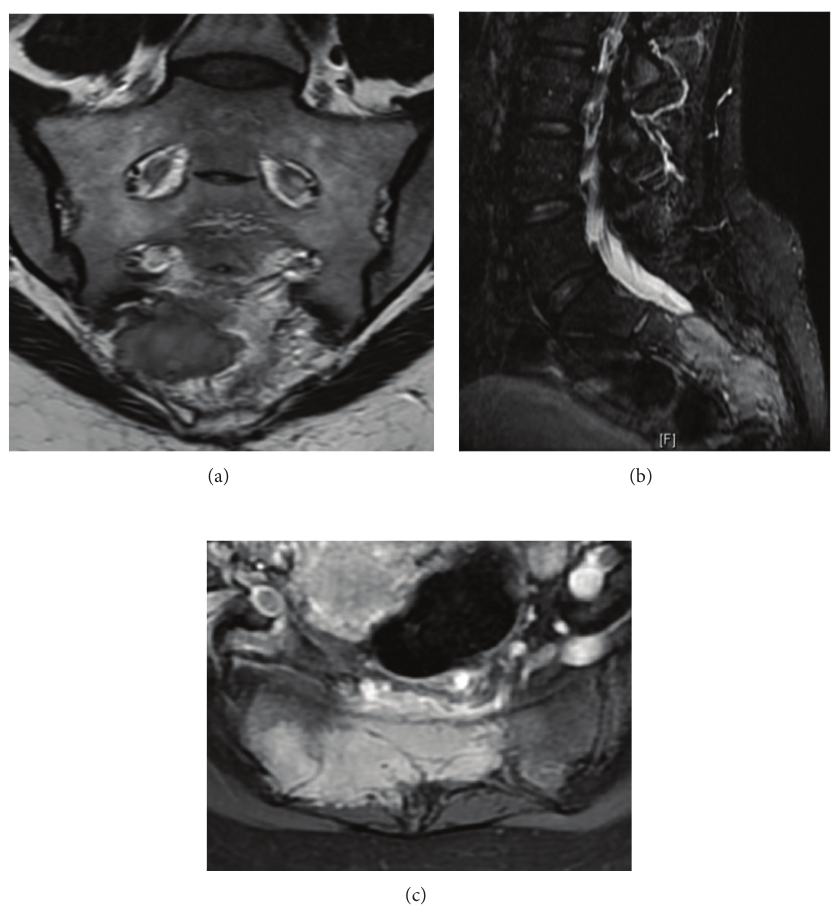
Figure 1: Preoperative T2-weighted contrast enhanced MRI showing an expansive and osteolytic lower and mid-sacral lesion, extending up to the inferior half of S2 vertebra, with both intra- and extracanalar components and a ventral extension displacing the rectum anteriorly. (a) Coronal, (b) sagittal, and (c) axial views.